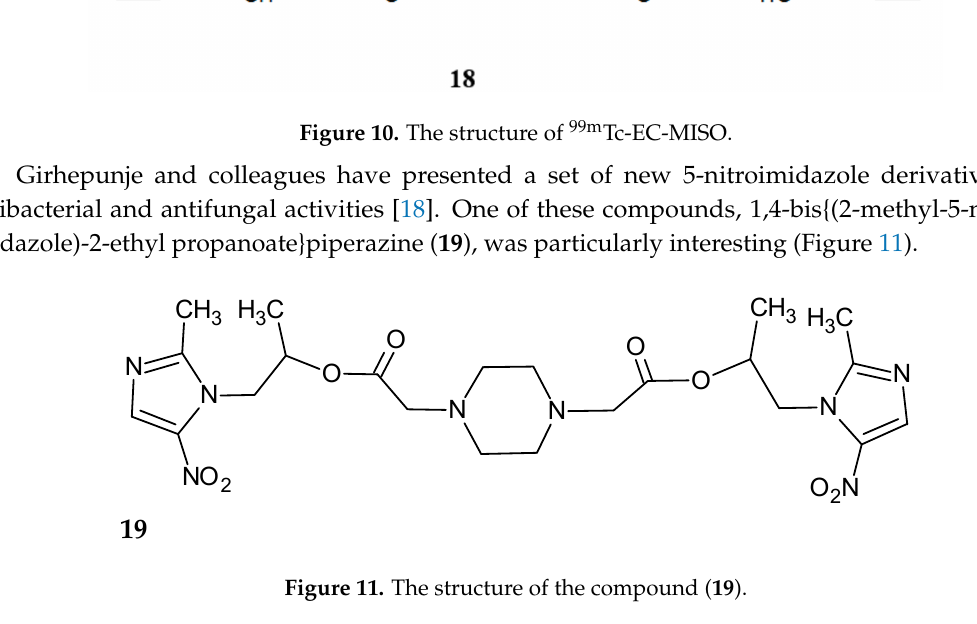
Figure 11. The structure of the compound ( 19 ).